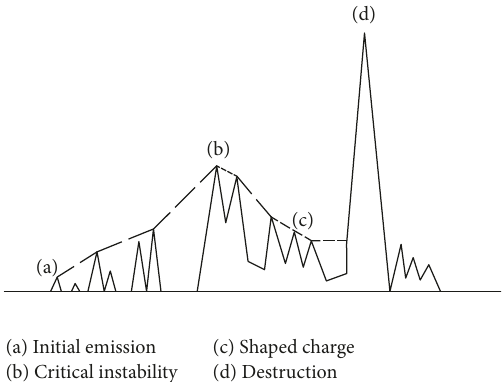
Figure 9: Curves of the general acoustic emission